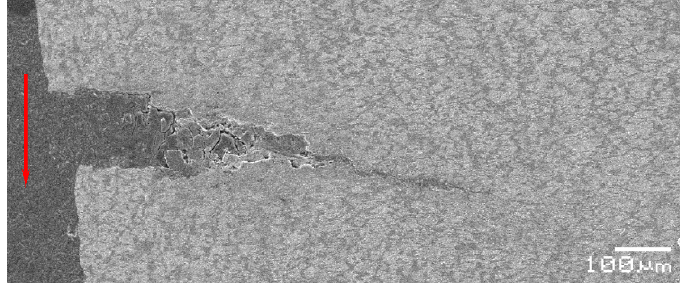
Figure 11. Coalescence of microcracks (red arrow—direction of upsetting).